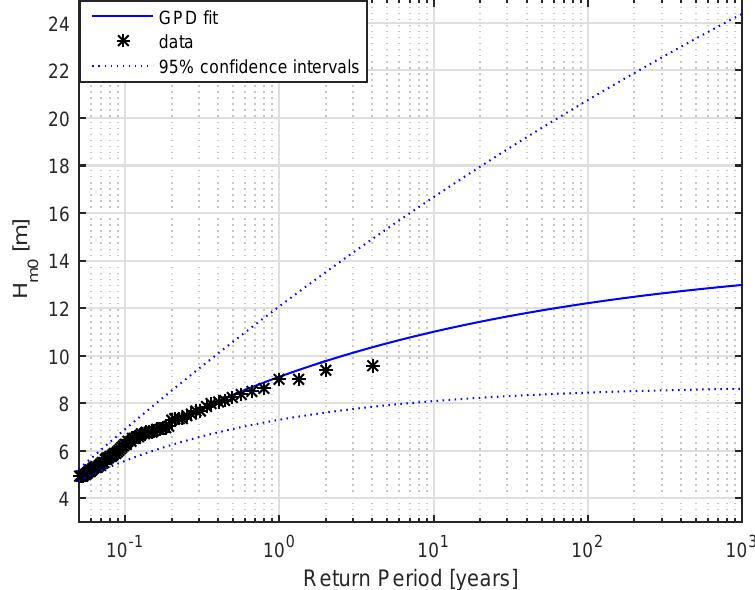
Figure 3. Resulting final GPD distribution for extreme significant wave heights using the chosen POT threshold of 4 m. 95% confidence intervals are also